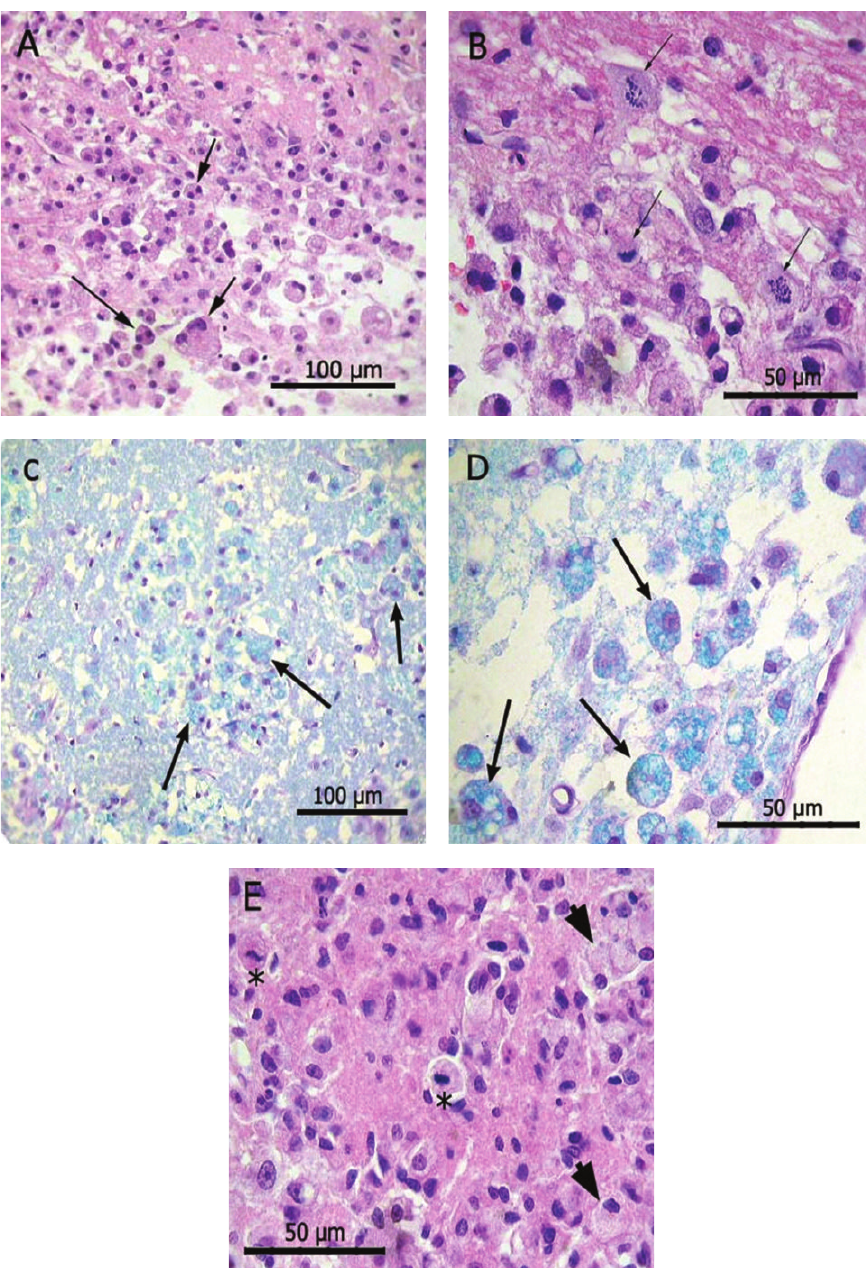
Figure 7: Macrophages in ischemic animals. A: Binucleate macrophages in the corpus callosum. H-E. B: Macrophages in mitosis in the corpus callosum. H-E. C: Macrophages in caudate putamen. Luxol fast blue y PAS. D: Macrophages near the lateral ventricle. Luxol fast blue y PAS. E: Macrophages with vacuolated cytoplasm in mitosis (asterisk) in thalamus. H-E. Model of focal ischemia. Macrophages (arrows) in several brain regions of ischemic